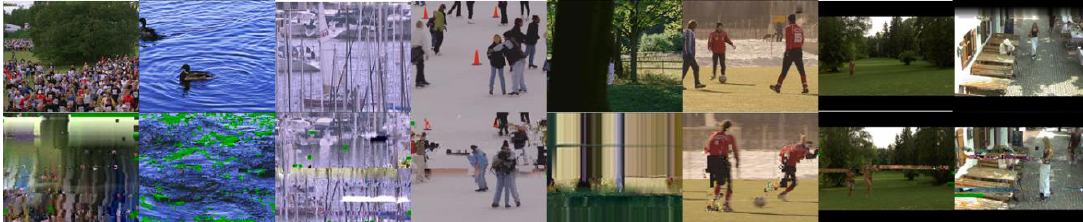
Figure 11. Samples of the videos in the ReTRiEVED dataset. The upper row shows the original videos and the bottom shows the attacked videos.